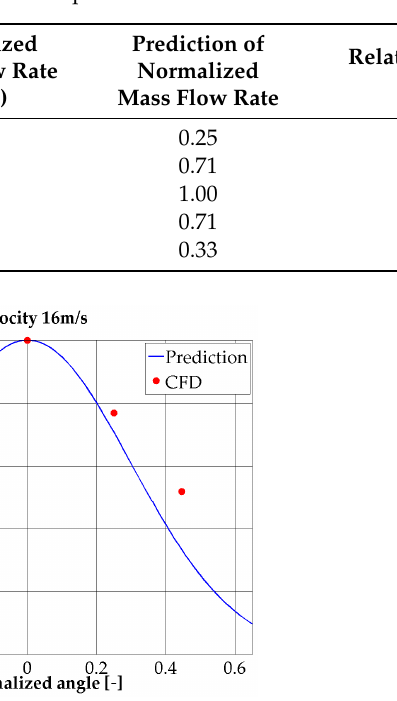
Table 4. Percentage relative error between CFD and empirical normalized airflow rate for 16 m / s.